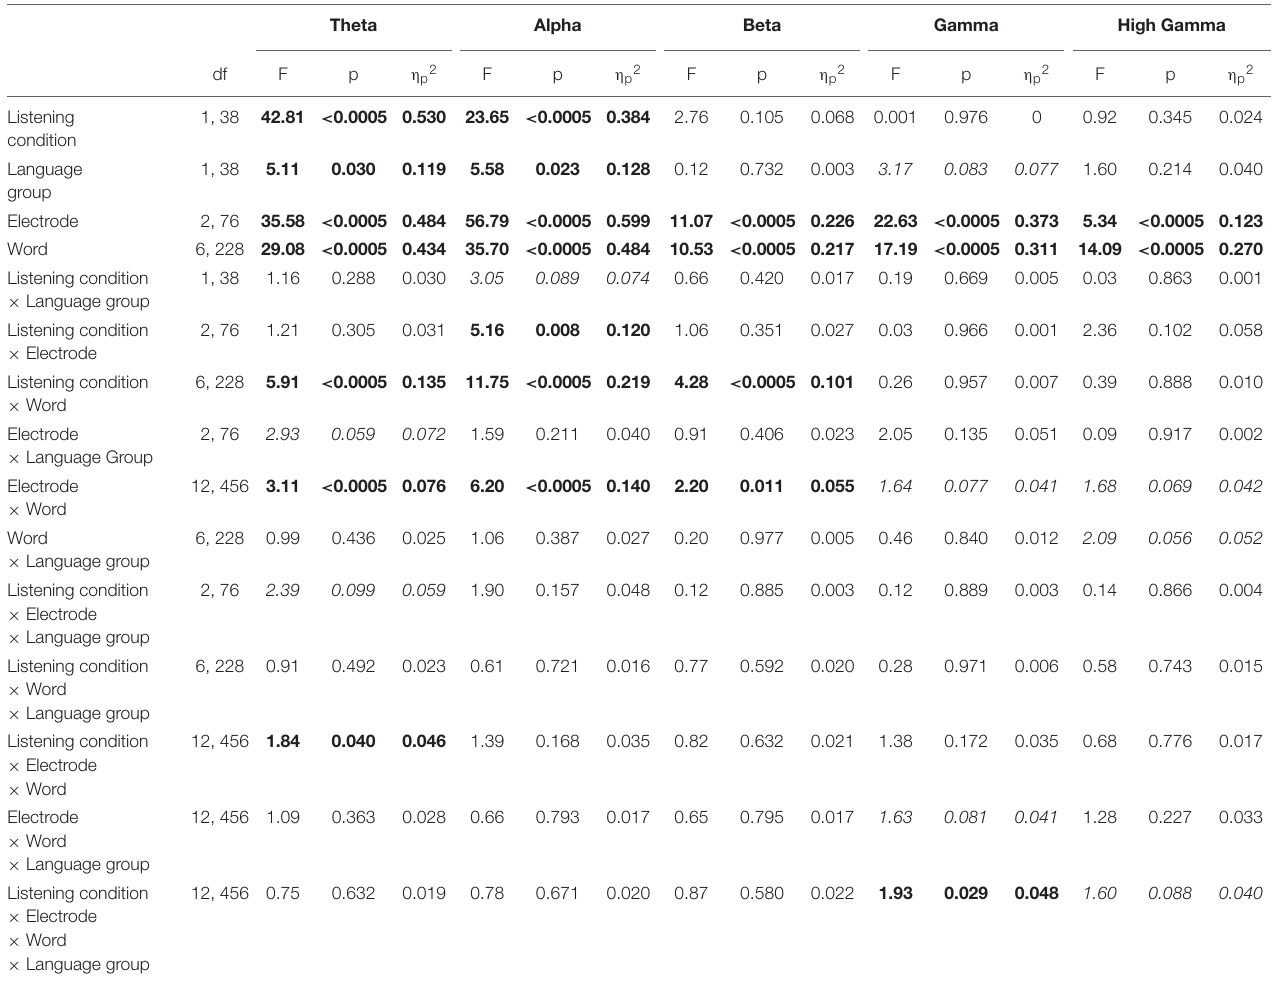
TABLE 3 | Cortical analyses within individual frequency bands. Theta Alpha Beta